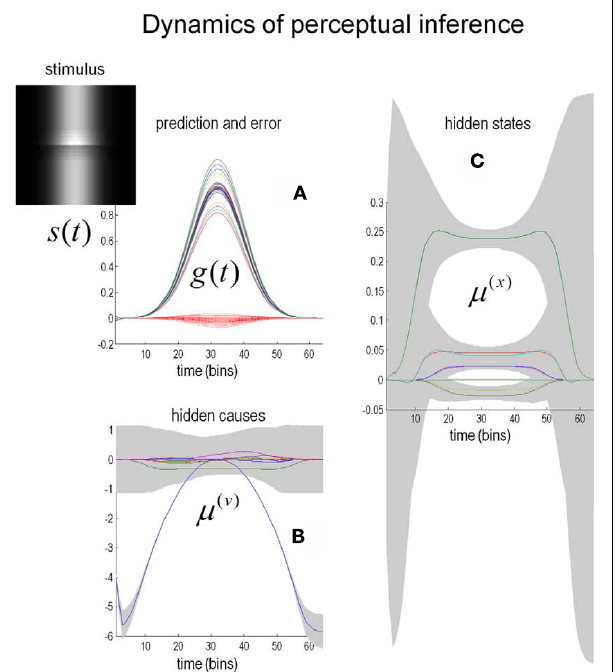
FIGURE 6 | Predictions of the model. (C) Shows the estimates of the hidden states (coefficients of the reflectance basis functions) over time. The hidden state controlling the amplitude of the lowest-frequency basis function, which corresponds to the Cornsweet percept, contributes substantially to the overall perception of the stimulus (green line).The estimates for the hidden causes are shown in (B) .The gray areas are 90% confidence intervals. (A) Shows predictions (solid lines) of sensory input based on the estimated hidden causes and states and the resulting prediction error (dotted red lines).The insert on the upper left shows the time-dependent luminance profile used in this simulation. Please see main text for further